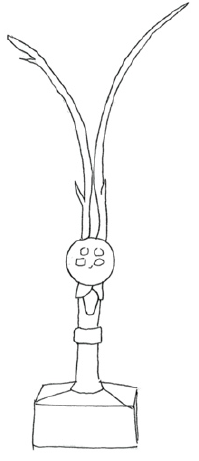
Figure 4. Line drawing of terra cotta antlered and tongued tomb sculpture excavated from Tomb 19 at Zilinggang, Jingmen, Hubei Province. Adapted from Jingmen shi bowuguan (2008, plate 25.6) courtesy of Zay Olsen.